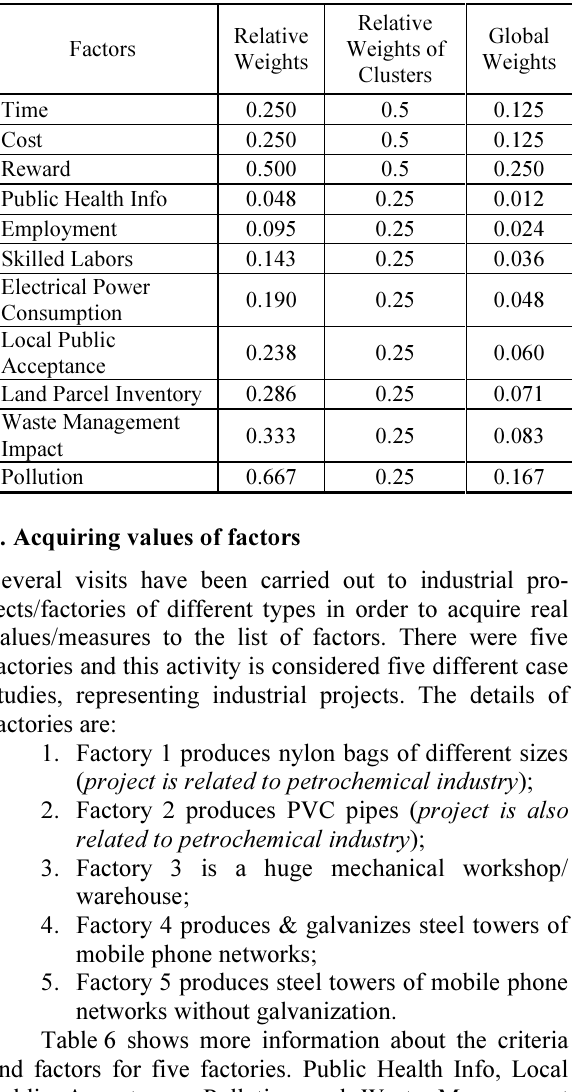
Table 5. Global weights of factors